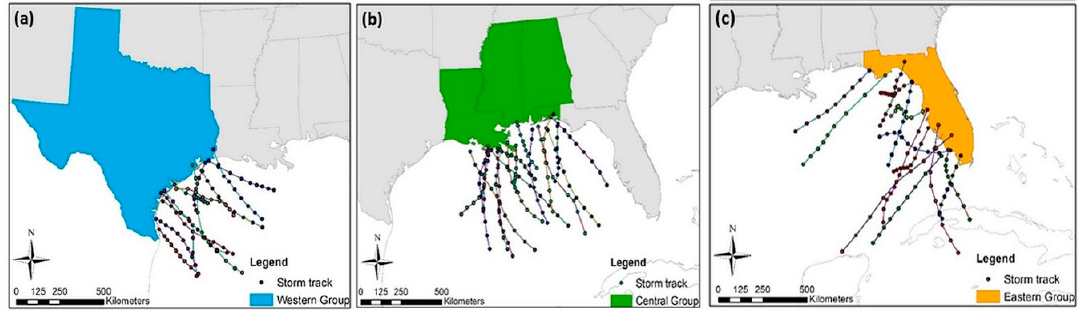
Figure 1. Three regional groups with storm center positions every 3 h from 24 h prior to landfall to the time closest to landfall. ( a ) Western group; ( b ) central group; ( c ) eastern group.